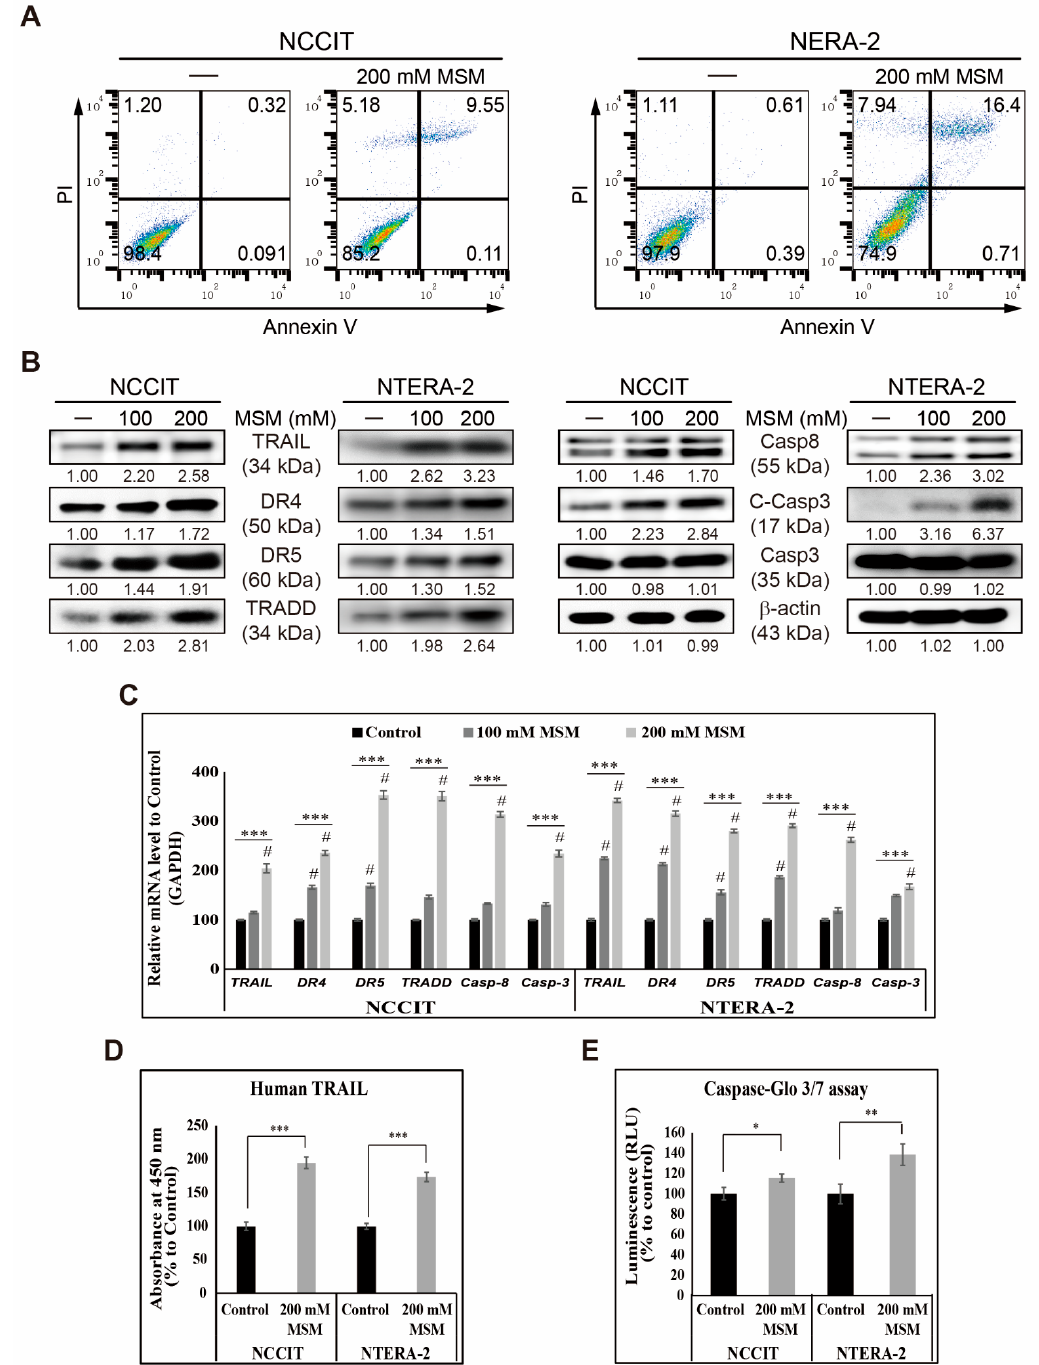
Figure 3. MSM induced extrinsic apoptosis pathway. ( A ) Fluorescein-conjugated annexin V (annexin V-FITC) vs. propidium iodide (PI) staining analysis showed apoptosis induction after treatment with 200 mM MSM for 48 h in NCCIT and NTERA-2 cells. ( B ) Western blotting of NCCIT and NTERA-2 cells with 100 and 200 mM MSM for 48 h showing the expression of TRAIL, DR4, DR5, TRADD, Casp8, Casp3, and C-Casp3 proteins. Expression levels were estimated by densitometry and normalized to β -actin. Data were in triplicate. ( C ) Real-time qPCR analysis showing illustrative expression of genes responsible for the extrinsic apoptosis pathway in NCCIT and NTERA-2 cells with 100 and 200 mM MSM for 48 h. Cp values were normalized to GAPDH mRNA. Controls were set at 100. *** p < 0.001 ( ANOVA test). # p < 0.001 vs. control. ( D ) Human TRAIL assay shows Human TRAIL elevation by 200 mM MSM treatment for 48 h in NCCIT and NERA-2 cells. Controls were set to 100. *** p < 0.001 (Student’s t -test). ( E ) Caspase-Glo 3/7 assay showing the enhancement of caspase-3/7 activity by 200-mM MSM treatment for 48 h. Controls were set at 100. * p < 0.05 and ** p < 0.01 (Student’s t